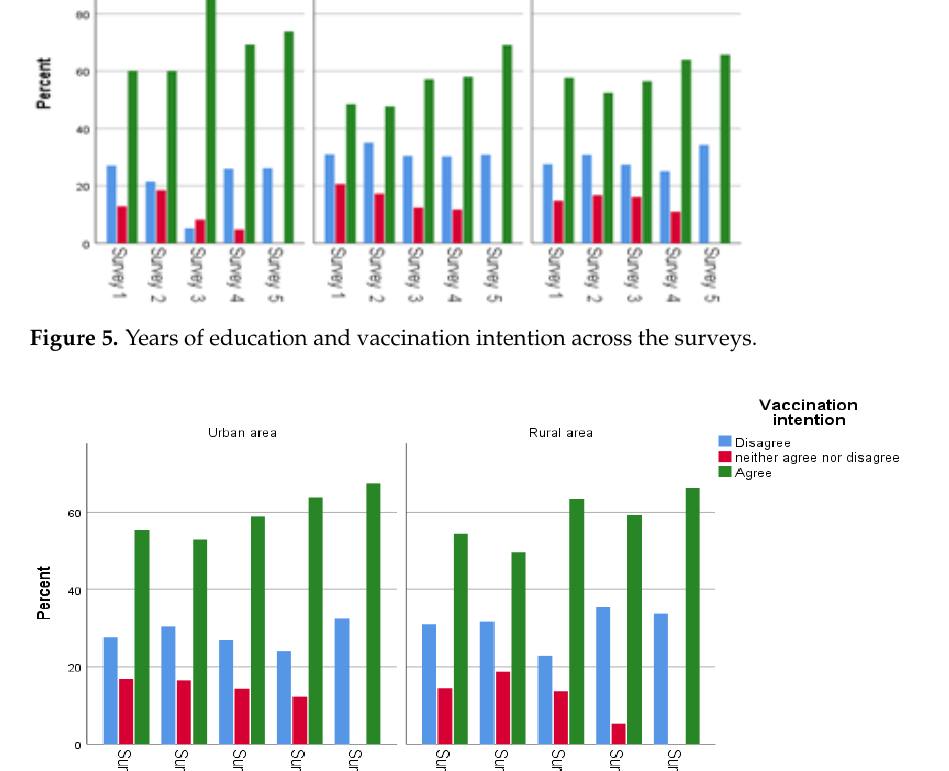
Figure 6. Area of residence and vaccination intention across the surveys.